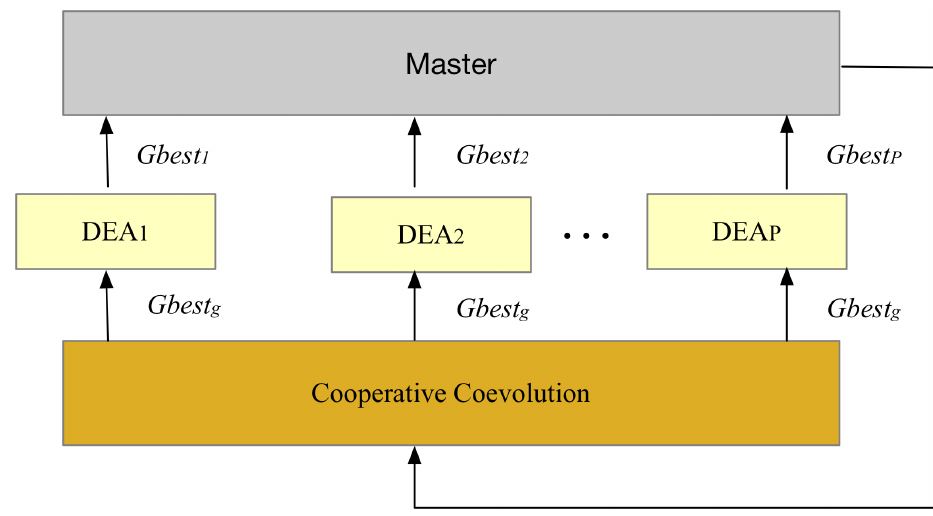
Figure 2. The evolution model of master–slave cooperative cooperation.